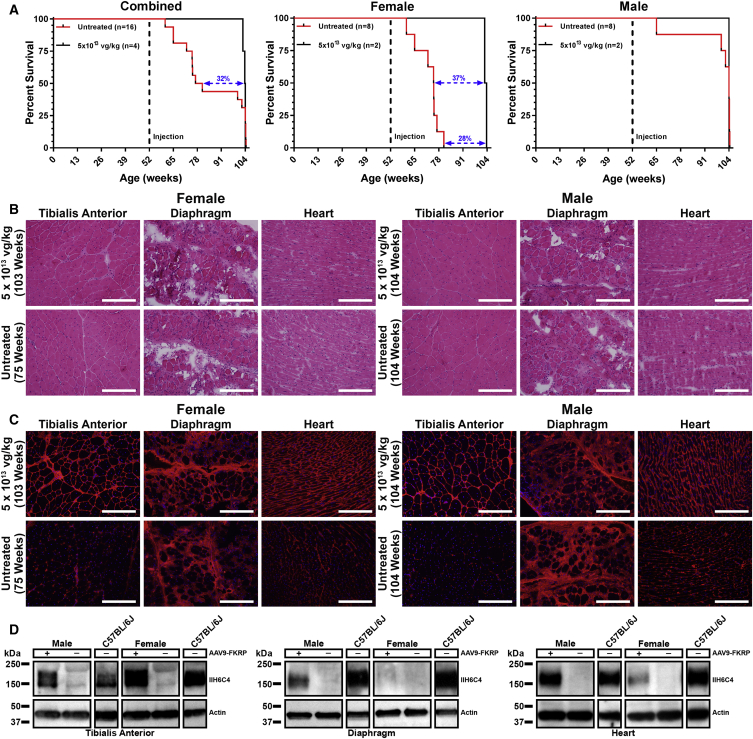
Effect of AAV9-FKRP Treatment on Longevity with a Focus on Gender Differences(A) Kaplan-Meier survival curves of combined mouse cohorts (left), female (middle), and male (right). The log rank (Mantel-Cox) test was used for statistical analysis. For the combined mouse cohorts, the difference in median survival is 32%. For the female cohorts, the difference in median survival is 37% (the difference in the longest-lived AAV9-FKRP-treated female compared to the longest-lived untreated FKRPP448L female is 28%). For the male cohorts, the difference in median survival is 0%. (B) H&E, (C) IIH6C4 staining, and (D) western blot analysis of tibialis anterior, diaphragm, and heart tissue cross-sections acquired from a female and male FKRPP448L mouse either treated with AAV9-FKRP at a dose of 5 × 1013 vg/kg at 52 weeks of age or untreated. Scale bars, 200 μm. Notes: high background (non-specific) signal is noticeable in both the diaphragm and heart. Age at sacrifice is in parentheses where applicable. Respective tissues from 52-week-old C57BL/6J mice were used as a positive control for western blot analysis. All lanes for each respective tissue were run on the same gel but were non-contiguous.